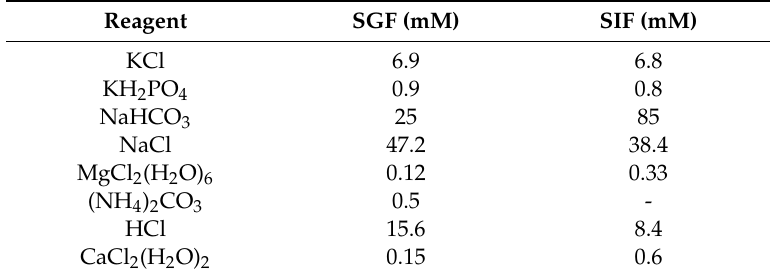
Table 1. Composition of the simulated gastric (SGF) and simulated intestinal (SIF)